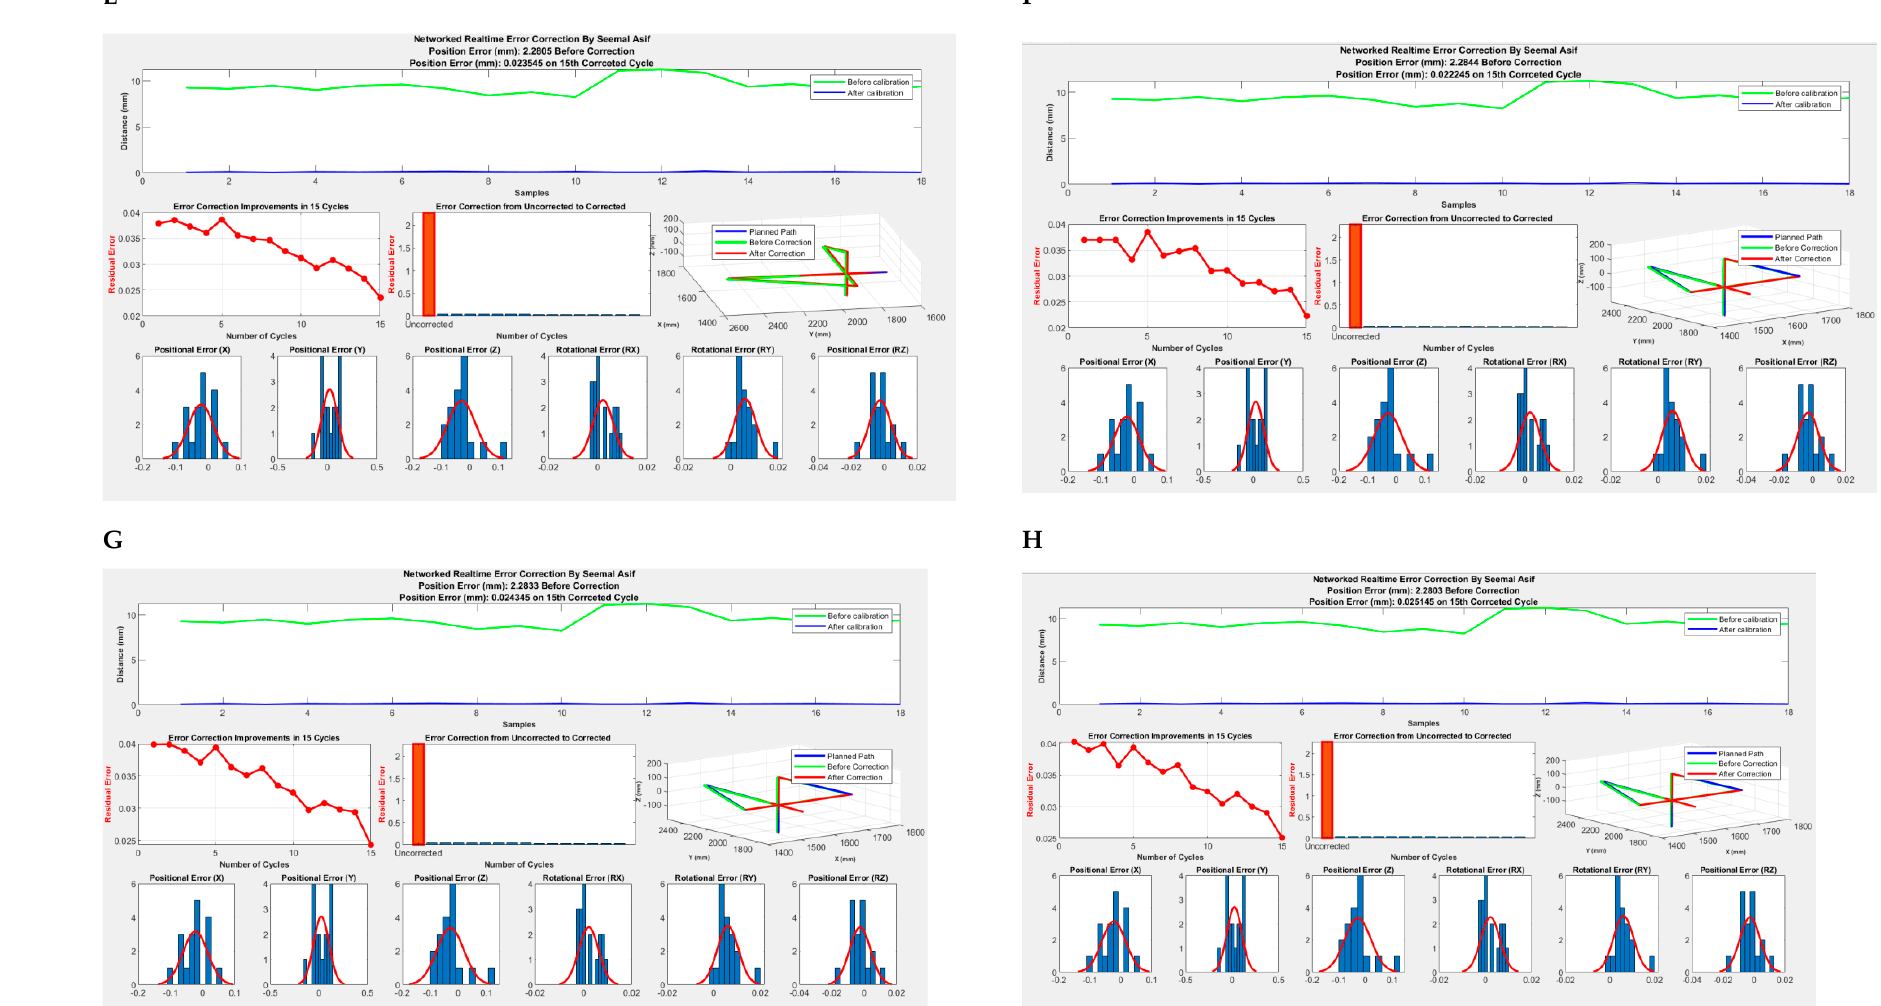
Figure 11. Achievement of correction with variable data sets ( A – H ).